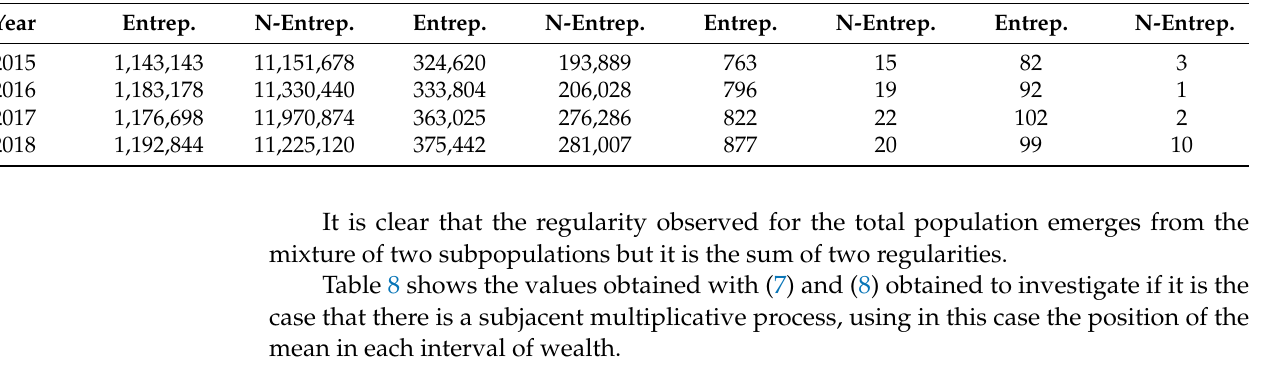
Table 8. Deviations with respect to multiplicative process of the